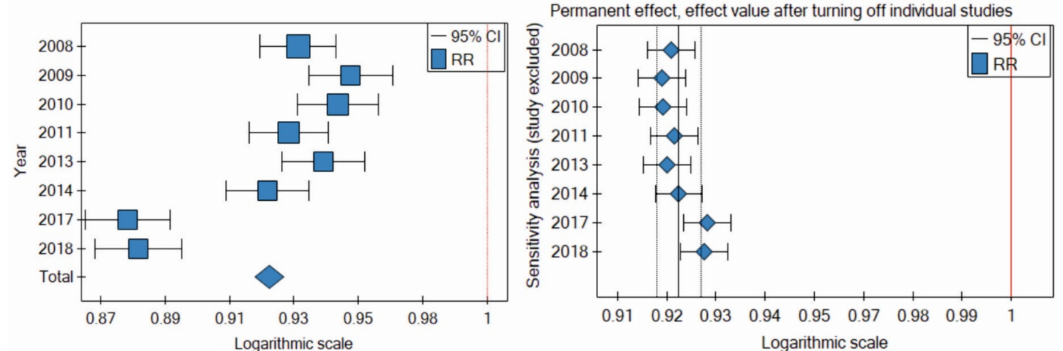
Figure 4. The relative risk of an accident at work among workers aged 30–39 years employed in Poland (own elaboration).